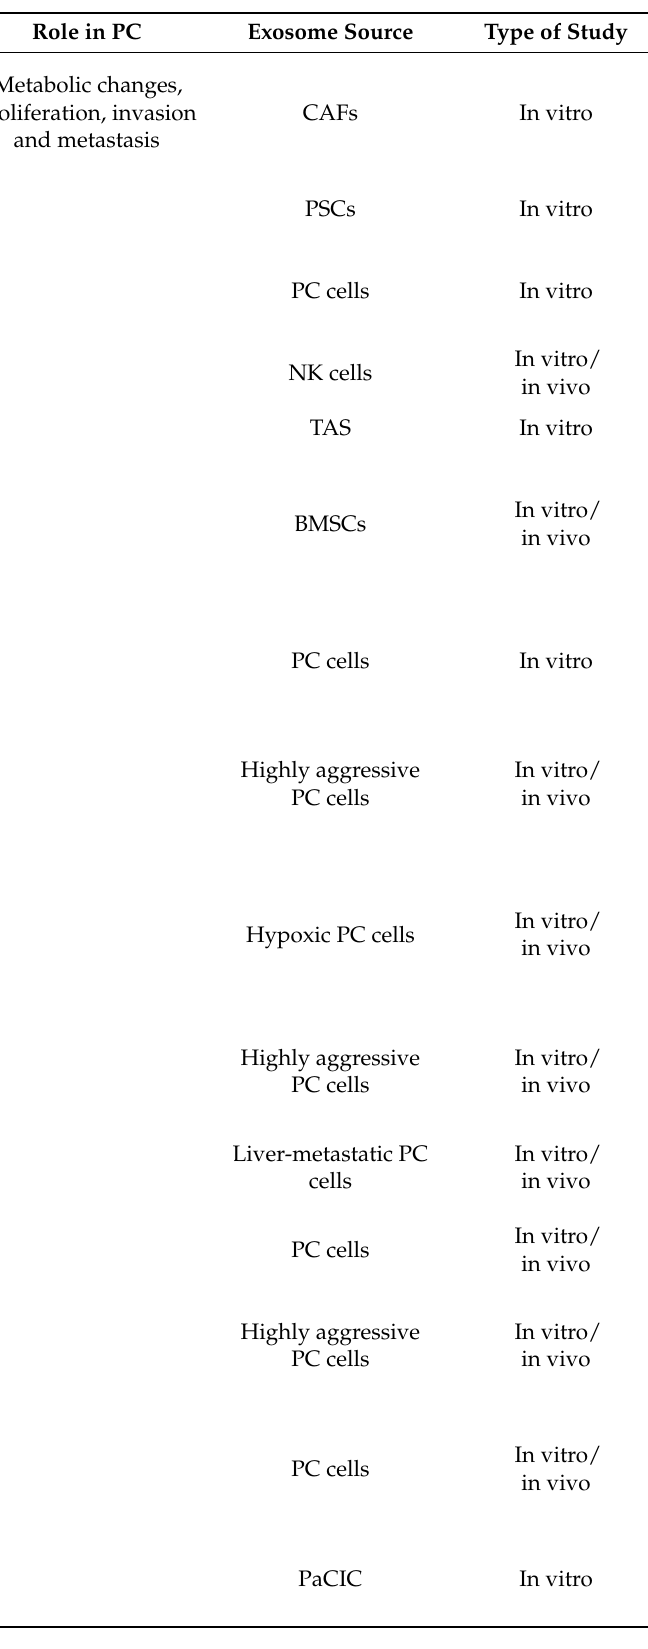
Table 1. Roles of exosomes in the pathogenesis and progression of pancreatic cancer.